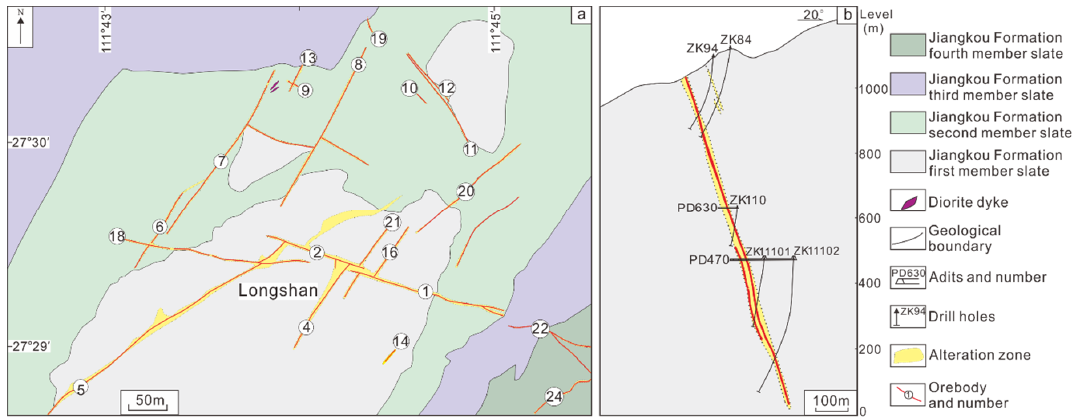
Figure 3. ( a ) Simplified geological map of the Longshan mining district in Longshan deposit, South China; ( b ) cross–section map of the Longshan mining district in Longshan deposit, South China (modified after Hunan Bureau of Geology and Mineral Resources [53]).